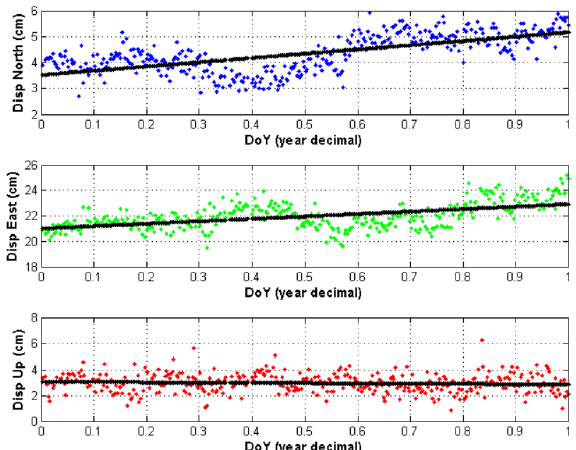
Figure 3. Graph for site velocity estimation based on GPS-